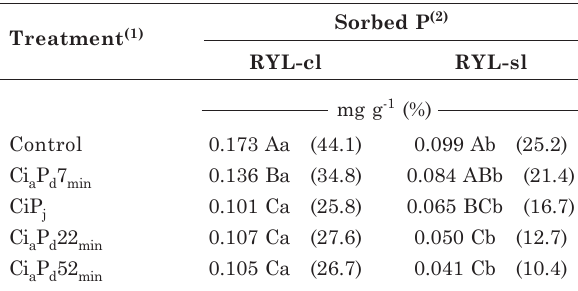
Table 2. Mean cumulative concentrations, in the sampling period of 0 to 62 min, of P sorbed to soil with clayey texture Oxisol (RYL-cl) and with sandy-loam texture Oxisol